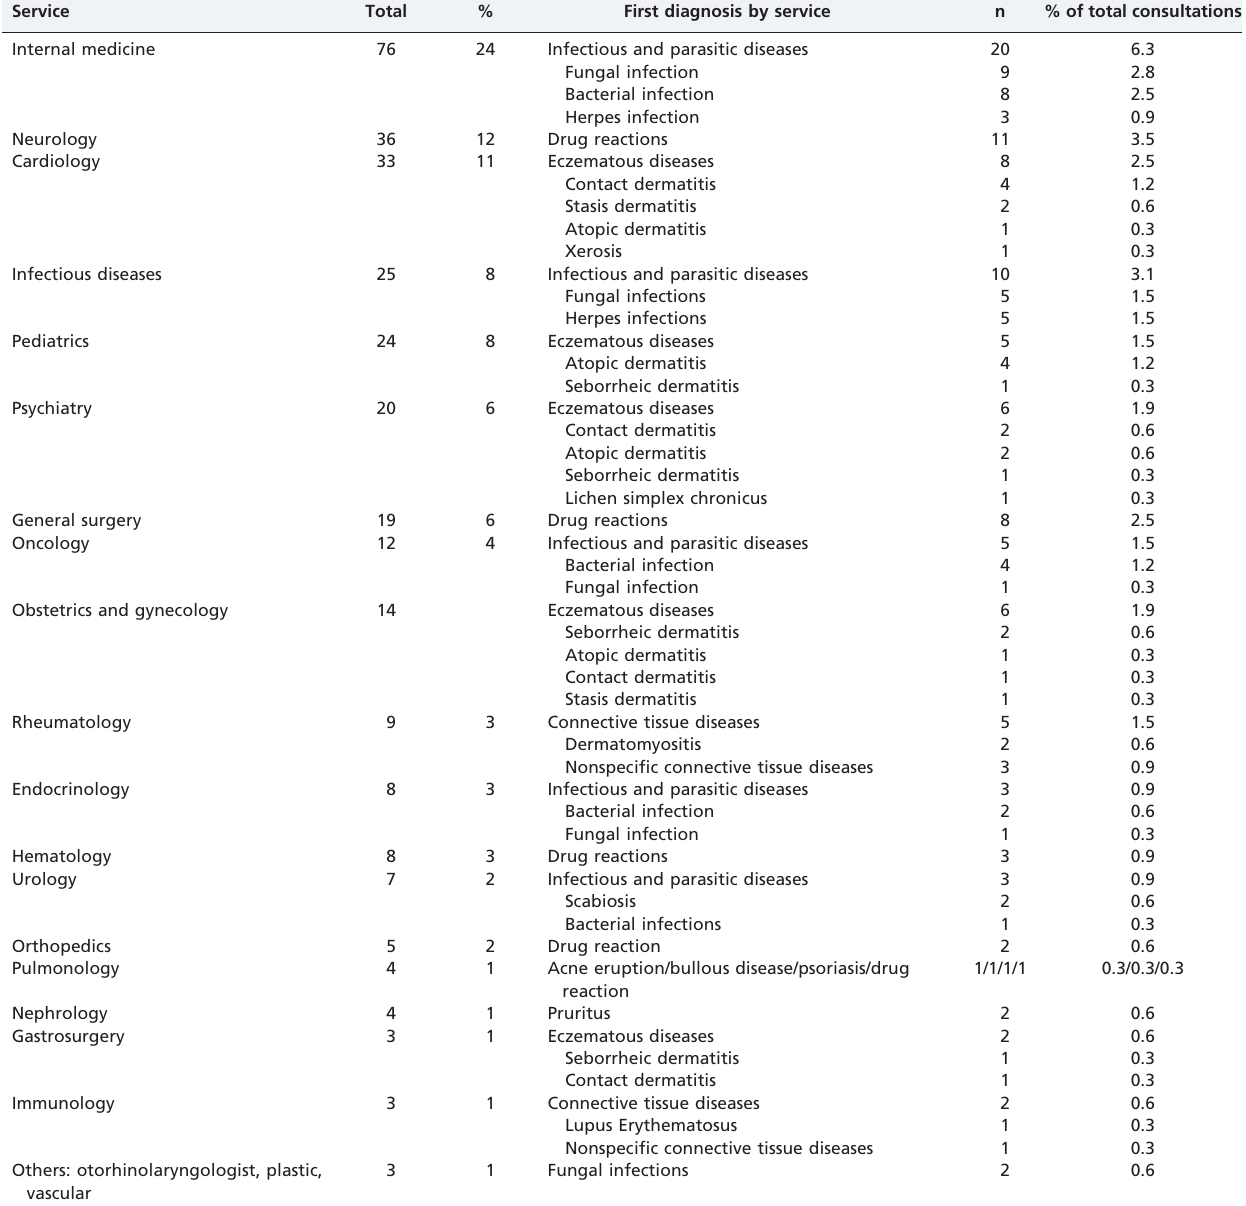
Table 1 - Referral services and most frequent diagnosis by